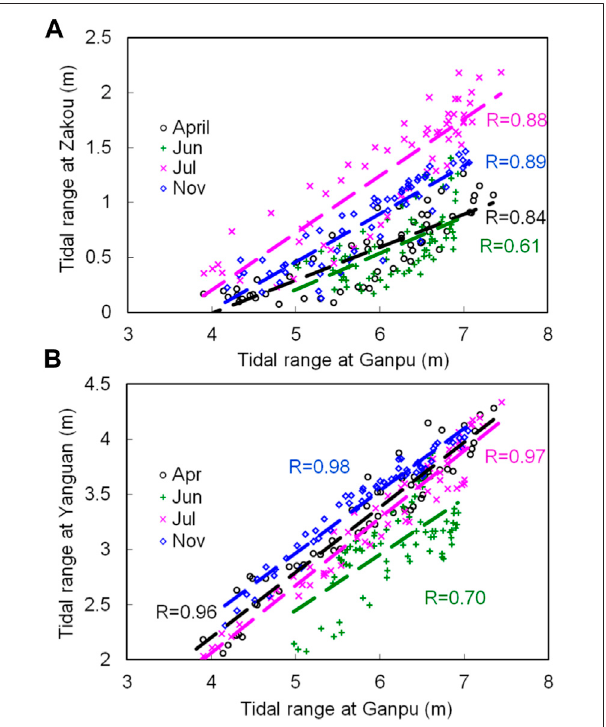
FIGURE 7 | The relationships between the tidal range at Zakou (A) and Yanguan (B) and that at Ganpu.